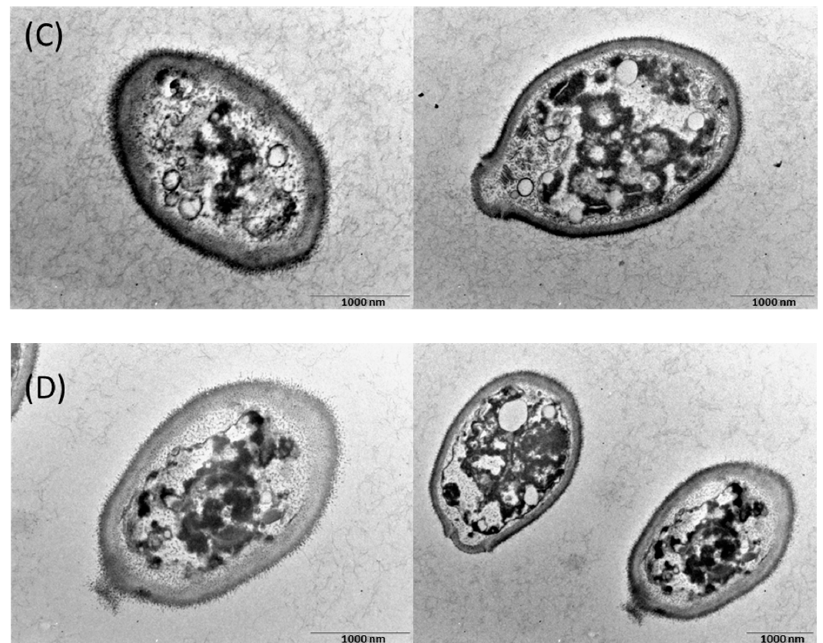
Figure 7. Transmission electron microscopy images of C. albicans cells. ( A ) Control; ( B ) in the presence of CKR12 ‐ PLGA = 64 μ M; ( C ) in the presence of MCZ = 199 μ M; ( D ) in the presence of CKR12 ‐ PLGA ‐ MCZ micelles = 64 μ M.